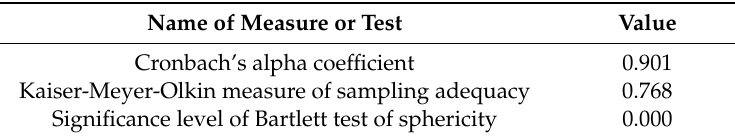
Table A3. Analysis of reliability and validity of the collected questionnaire data about the system usability of the proposed interactive